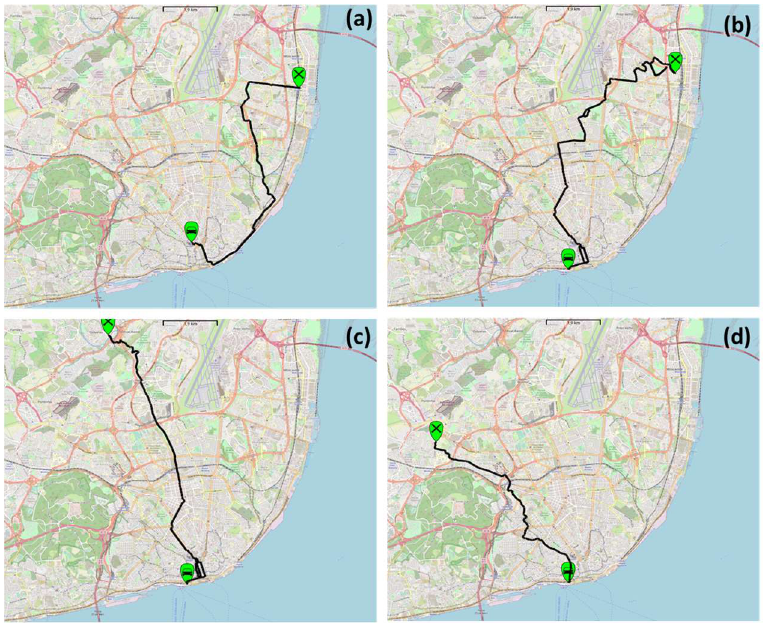
Figure 2. Bus routes selected for the measurements campaign: ( a ) Restauradores—Oriente; ( b ) Restauradores—Moscavide; ( c ) Odivelas—Cais do Sodré and ( d ) Portas de Benfica—Cais do Sodré. Table 1. Bus Routes starting and ending points and hierarchical levels.